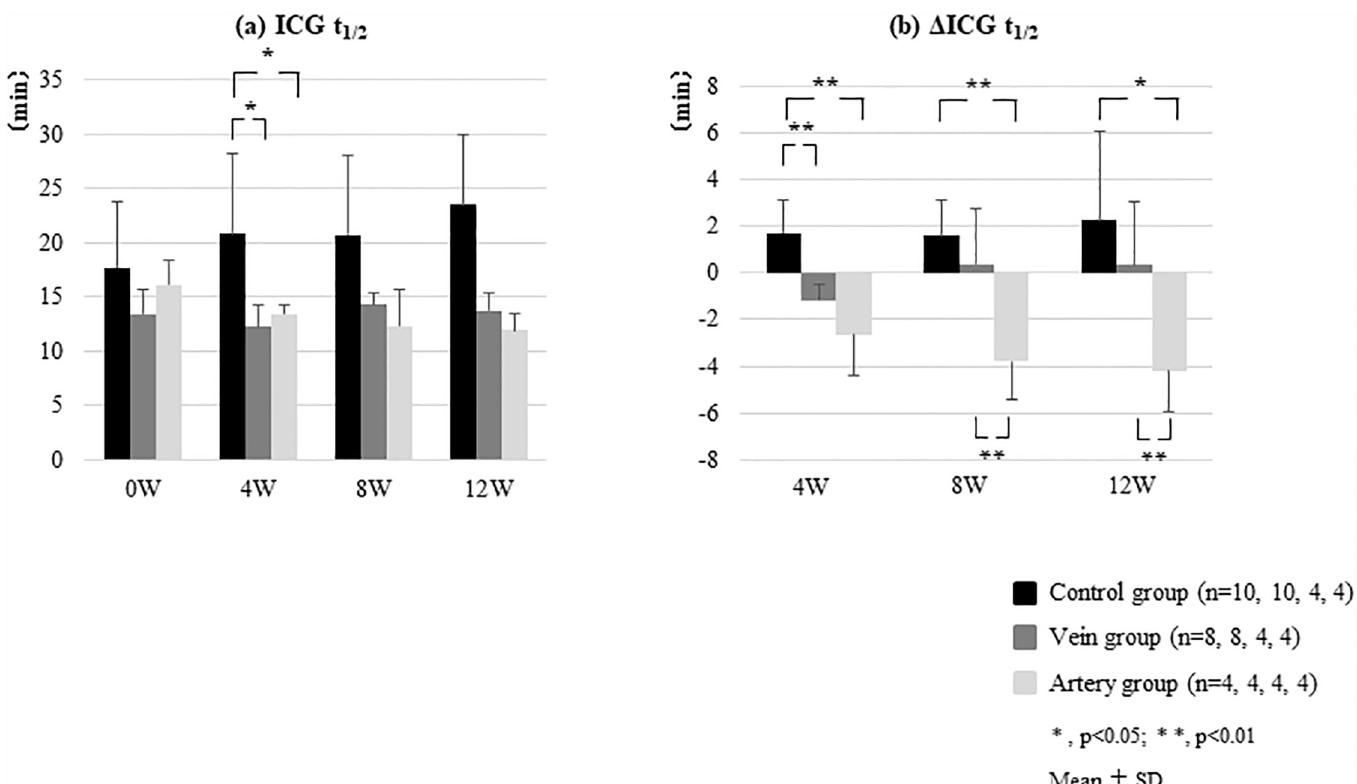
Fig 5. Therapeutic effects of transfused BMSCs in a CCl 4 -induced canine liver fibrosis model. After the induction of liver fibrosis, canines were treated with BMSCs via the peripheral vein (Vein group) or hepatic artery (Artery group). (a) Indocyanine green (ICG) half-life (t 1/2 ) in the Vein group was slightly decreased at 4 weeks post- BMSC administration, from 13.4 ± 2.3 min (0W) to 12.2 ± 2.0 min (4W), but increased from 8 weeks onward to 14.3 ± 1.1 min (8W) and 13.7 ± 1.7 min (12W). In the Artery group, the ICG t 1/2 decreased from 16.1 ± 2.3 min (0W) to 13.4 ± 0.8 min (4W), and this value was subsequently maintained (12.3 ± 3.3 min (8W), 12.0 ± 1.5 min (12W)). (b) The Δ ICG t 1/2 value was significantly decreased in the Vein group compared to that in the Control group at 4 weeks post-BMSC administration ( Δ ICG t 1/2 (min): − 1.2 ± 0.7 vs. 1.7 ± 1.4; p < 0.01). Moreover, the ICG t 1/2 in the Artery group (n = 4) was significantly decreased at 8 weeks ( Δ t 1/2 : − 4.2 ± 1.7 min vs. +0.4 ± 2.7 min; p < 0.01) and 12 weeks after BMSC administration ( Δ t 1/2 : − 4.2 ± 1.7 min vs. +0.4 ± 2.7 min; p < 0.05) even when compared to that in the Vein group. All error bars represent the standard deviation of the